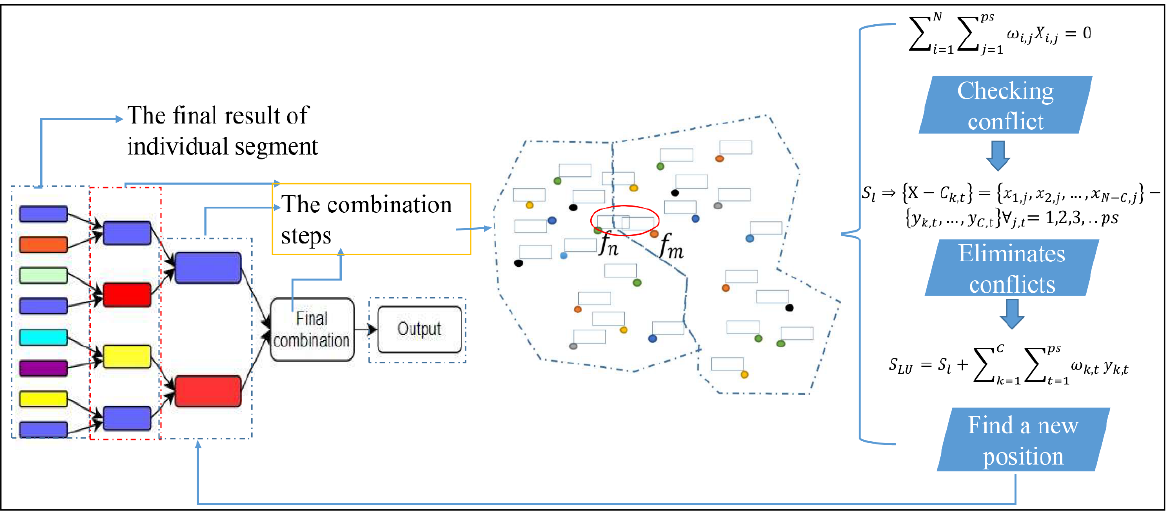
Figure 6. The process of recombining the results of all segmentations and checking if there is any label conflict.